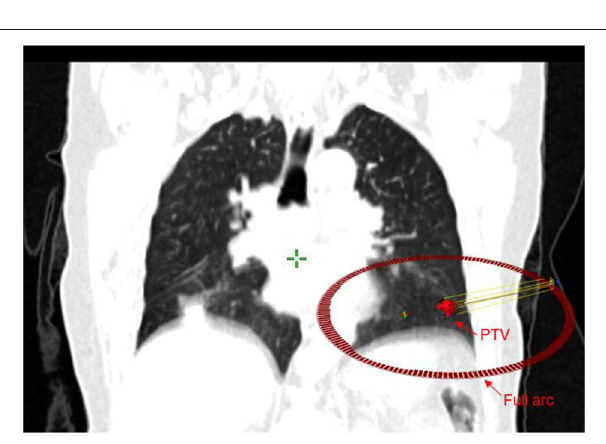
using the CBCT image database (18). Then, we registered the CBCT image and FBCT image and projected the ITV predict on the FBCT image to calculate the dose. The model workflow is shown in Figure 1